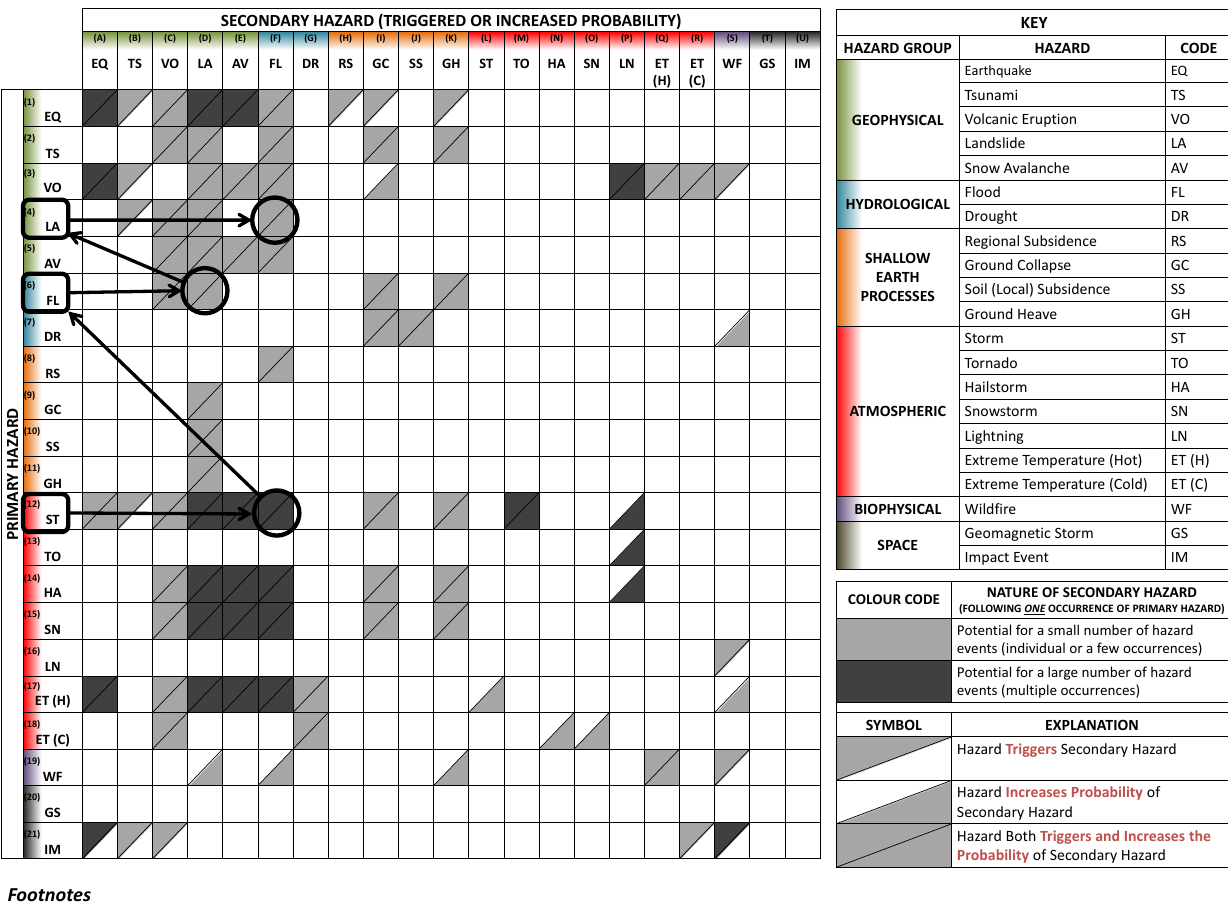
Figure 4. An example of a network of hazard interactions (a cascade system) (from Gill and Malamud, 2014) using a hazard interaction matrix. A 21 × 21 matrix with primary natural hazards on the vertical axis and secondary hazards on the horizontal axis. These hazards are coded, as explained in the key. This matrix shows cases where a primary hazard could trigger a secondary hazard (upper triangle shaded) and cases where a primary hazard could increase the probability of a secondary hazard being triggered (bottom triangle shaded). Where both triangles are shaded, this indicates that the primary hazard could both trigger and increase the probability of a secondary hazard. Also distinguished are those relationships where a primary hazard has the potential to trigger or increase the probability of multiple occurrences of the secondary hazard (dark grey) and few or single occurrences of the secondary hazard (light grey). Hazards are grouped into geophysical (green), hydrological (blue), shallow Earth processes (orange), atmospheric (red), biophysical (purple) and space/celestial (grey). Footnotes give further information about some of the relationships. This matrix can be used to present an example of a network of hazard interactions (cascade). In this network of hazard interactions example (illustrated using rectangles, circles and arrows overlaid on the matrix), a storm event (ST) triggers flooding (FL), which then triggers landslides (LA). These landslides (LA) may then trigger or increase the probability of further flooding (FL) through the blocking of a river or the increase in sediment within the fluvial